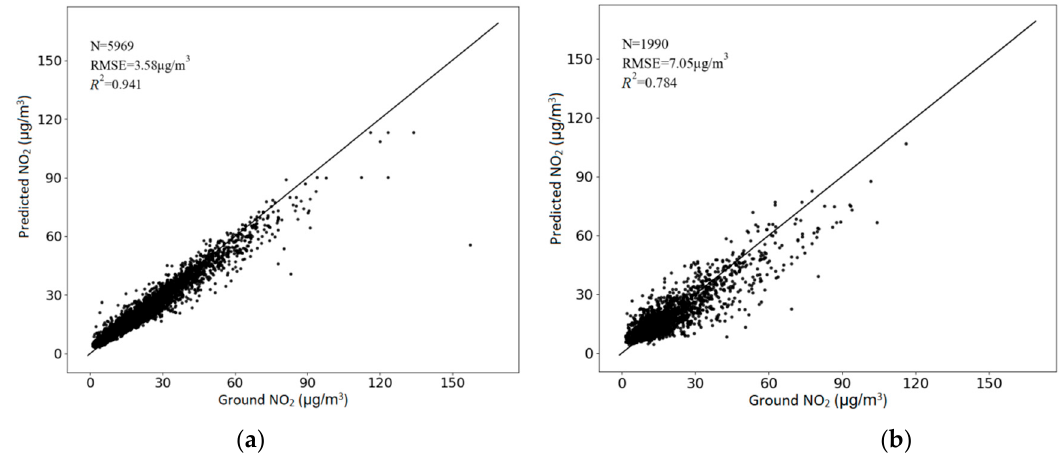
Figure 7. The correlation between predicted near ‐ surface NO 2 concentration results by RF model and measurements from ground sites: ( a ) training set and ( b ) test set. and measurements from ground sites: ( a ) training set and ( b ) test set. Table 5. Evaluation results of the RF model in the training set and test set. Table 5. Evaluation results of the RF model in the training set and test